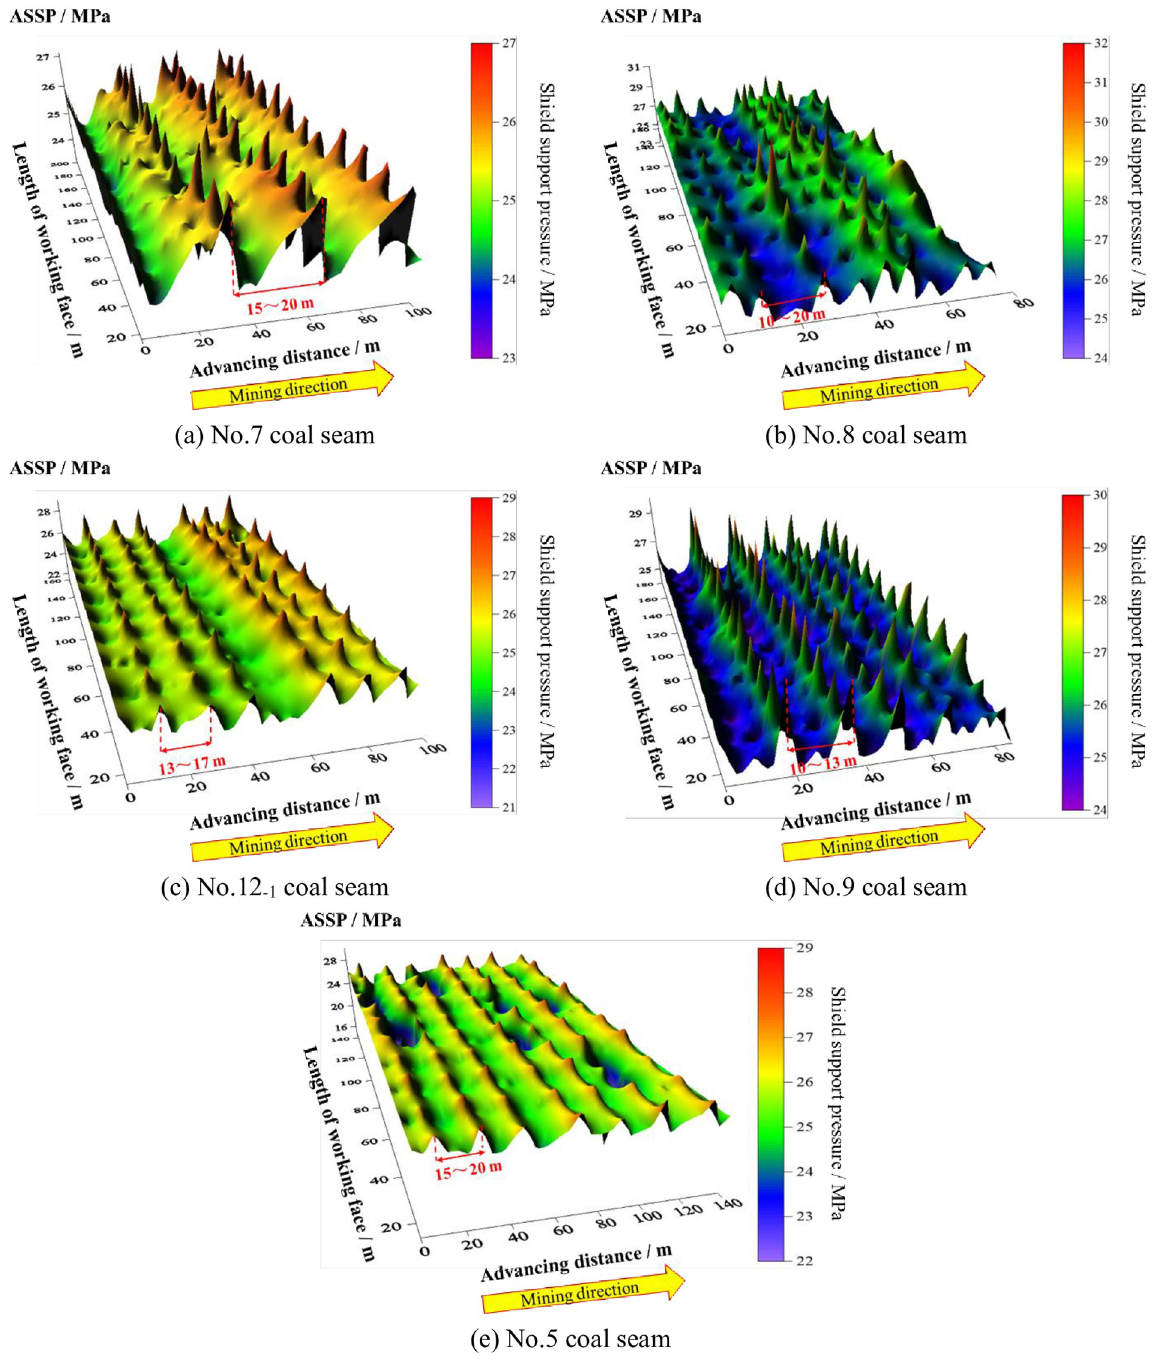
Fig 15. Field measurement results. (a) No.7 coal seam; (b) No.8 coal seam; (c) No.12 -1 coal seam; (d) No.9 coal seam; and (e) No.5 coal